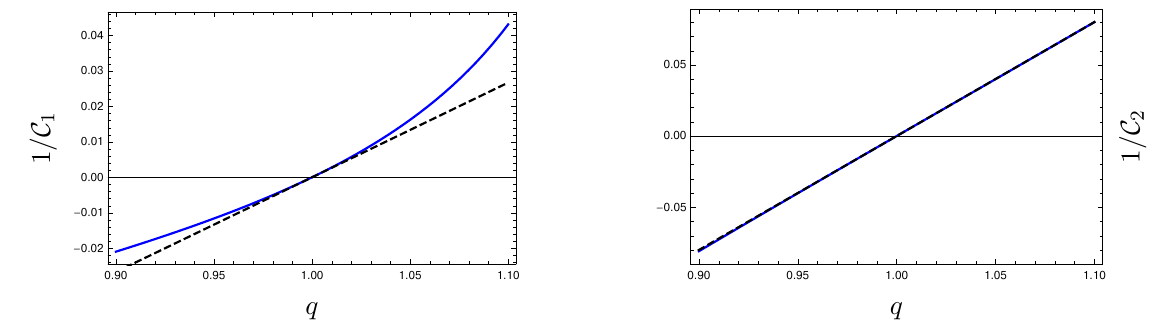
(the left panel, (6.67)) and C 1